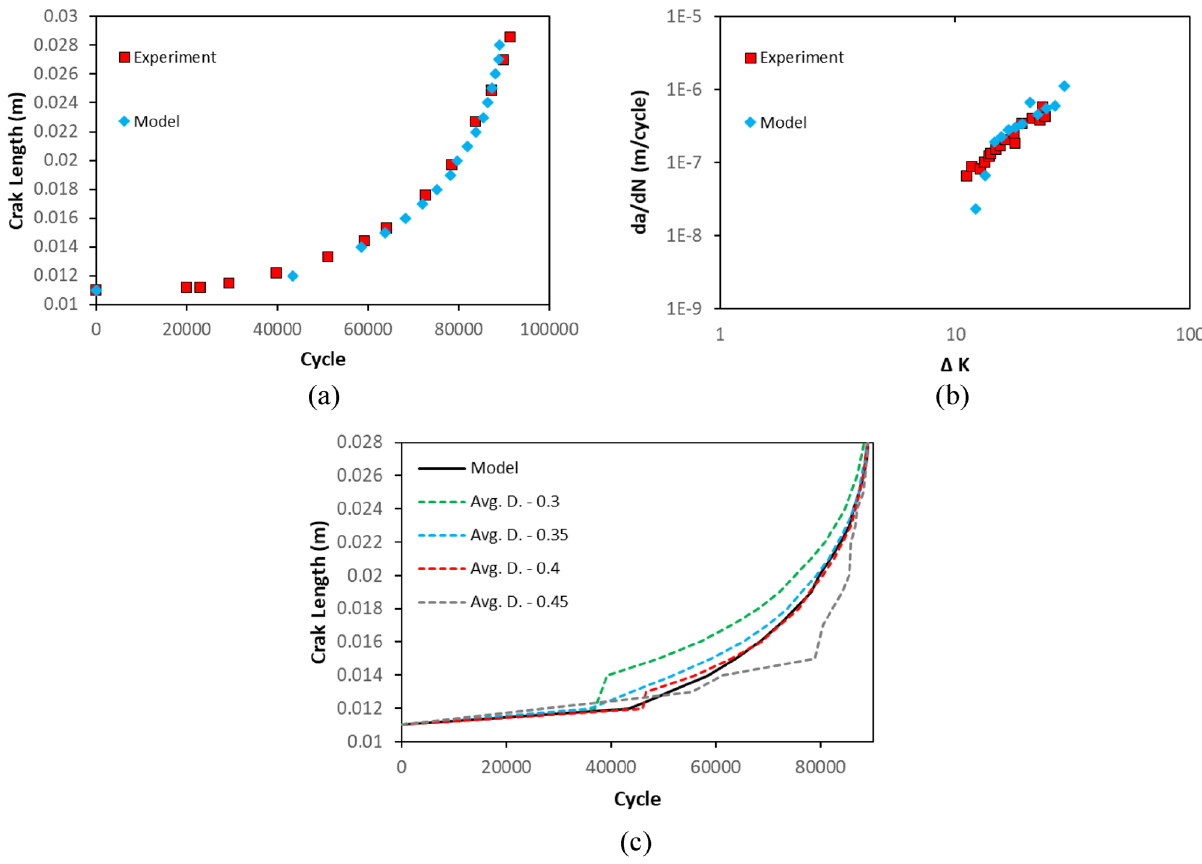
Figure 6. ( a ) A comparison between experimental data and the method in terms of crack length vs cycles. ( b ) A comparison between experimental data and the method in terms of crack propagation speed vs stress intensity factor. ( c ) A comparison between different nodal damage values vs the method in terms of crack length vs